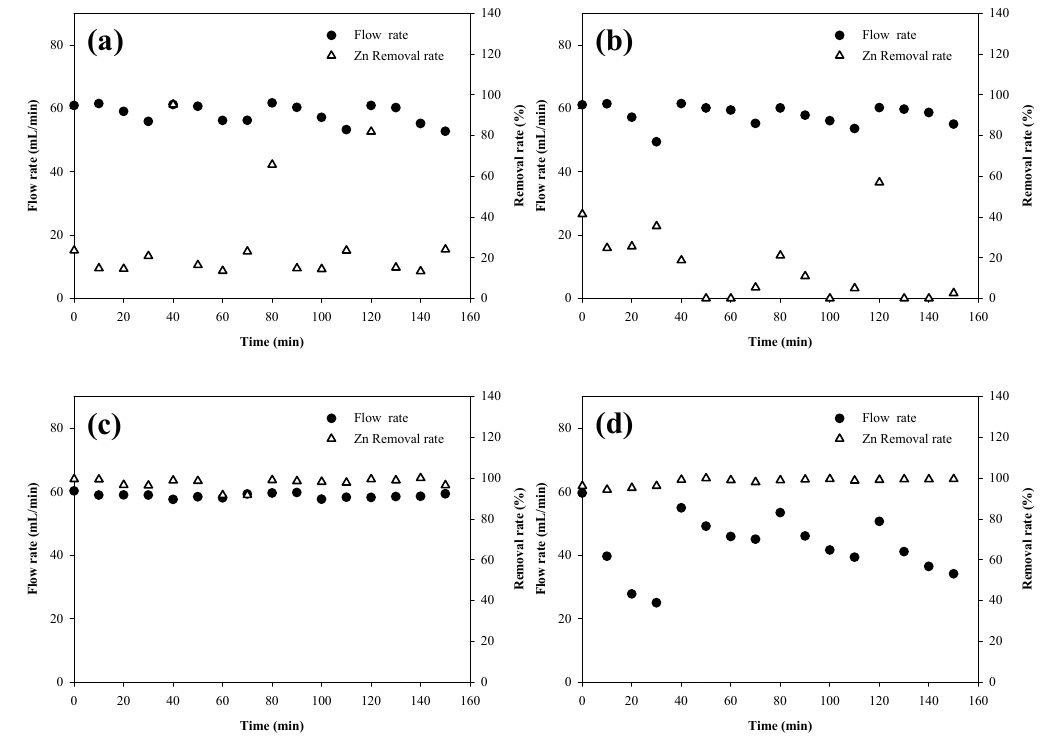
Figure 5. Effect of solution pH on the flow rate and Zn(II) removal rate during the hybrid ion-exchange fabric/ceramic membrane process in Zn + Kaolin solution: (a) pH 4, (b) pH 6, (c) pH 8, and (d) pH 10.